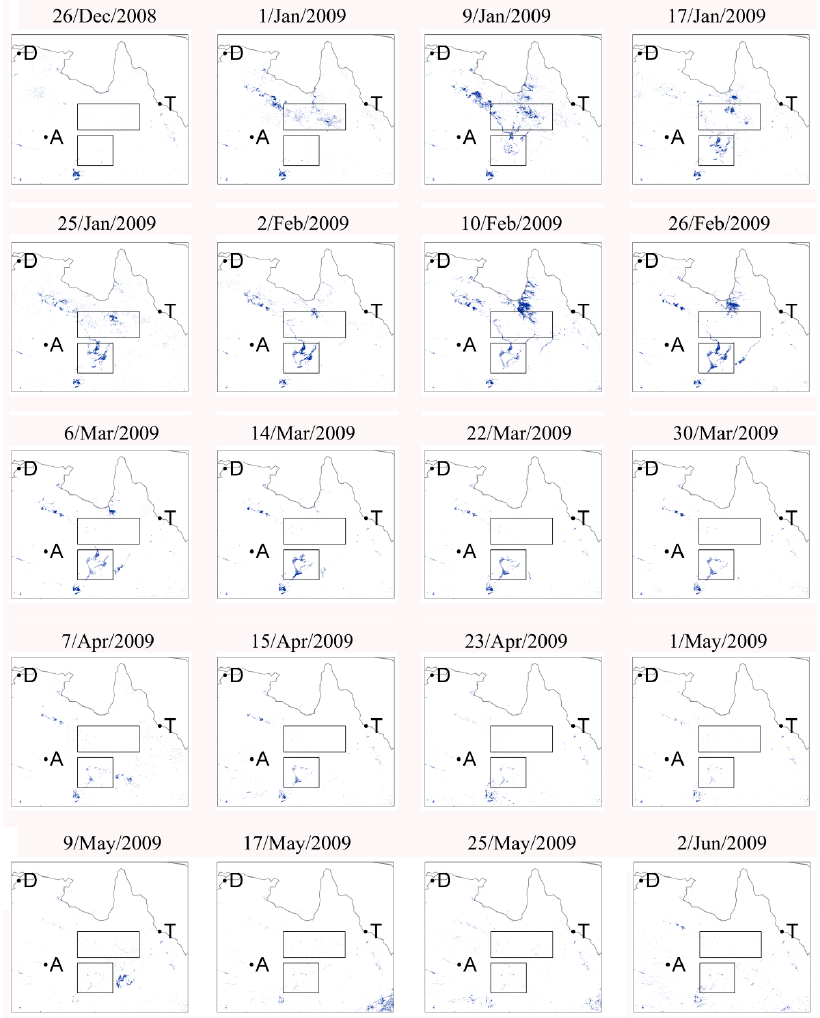
Figure 3. Mapping of surface water using the MODIS Open Water Likelihood (OWL) product from 26 December 2008 to 2 June 2009 using a threshold of 6%. Data in 18 February 2009 is not available due to cloud contamination.